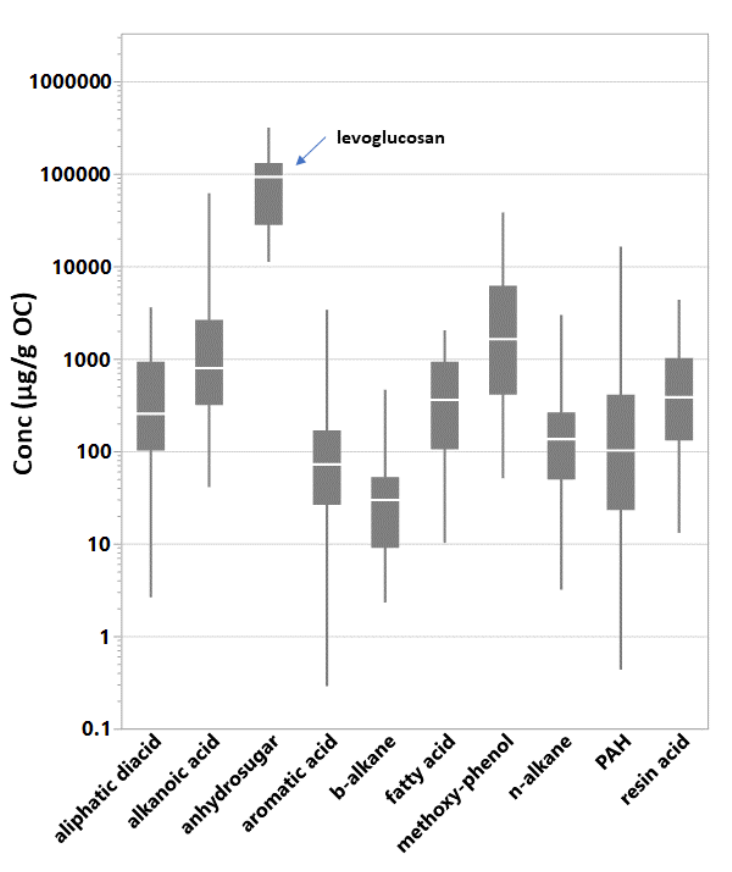
Figure 1. Quantile box plots of individual SVOC concentrations pooled by compound class. Levoglucosan is the anhydrosugar. The line in the box is at the median. The whiskers indicate the 10% and 90% quantiles. SVOC data populations (Table 2): aliphatic diacid ( n = 81); alkanoic acid ( n = 160); anhydrosugar ( n = 15); aromatic acid ( n = 103); b -alkane ( n = 30); fatty acid ( n = 48); methoxy-phenol ( n = 84); n -alkane ( n = 296); polycyclic aromatic hydrocarbons (PAH) ( n = 332); resin acid ( n =